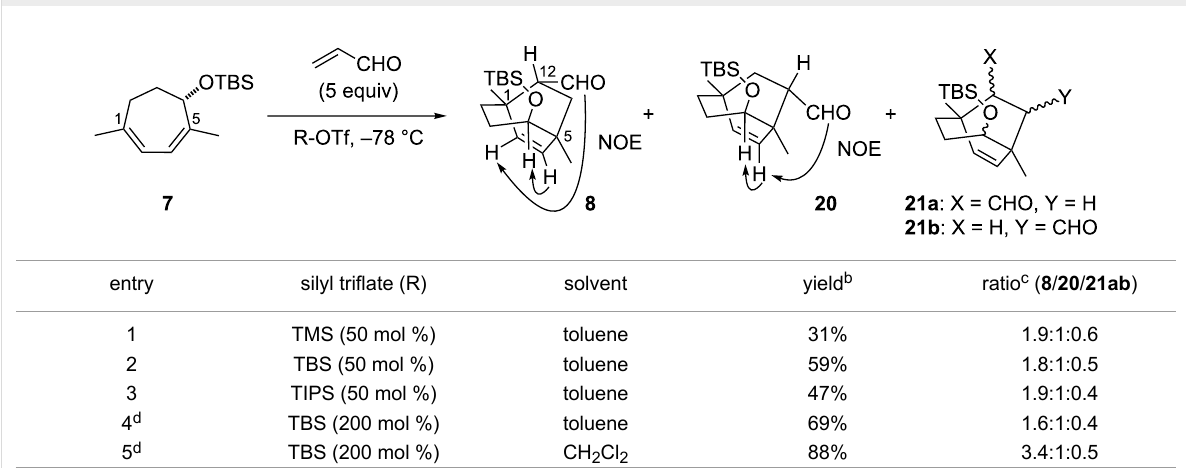
Table 1: Optimization of the Diels–Alder reaction.